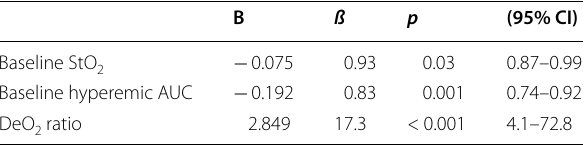
Table 2 Multivariate regression analysis